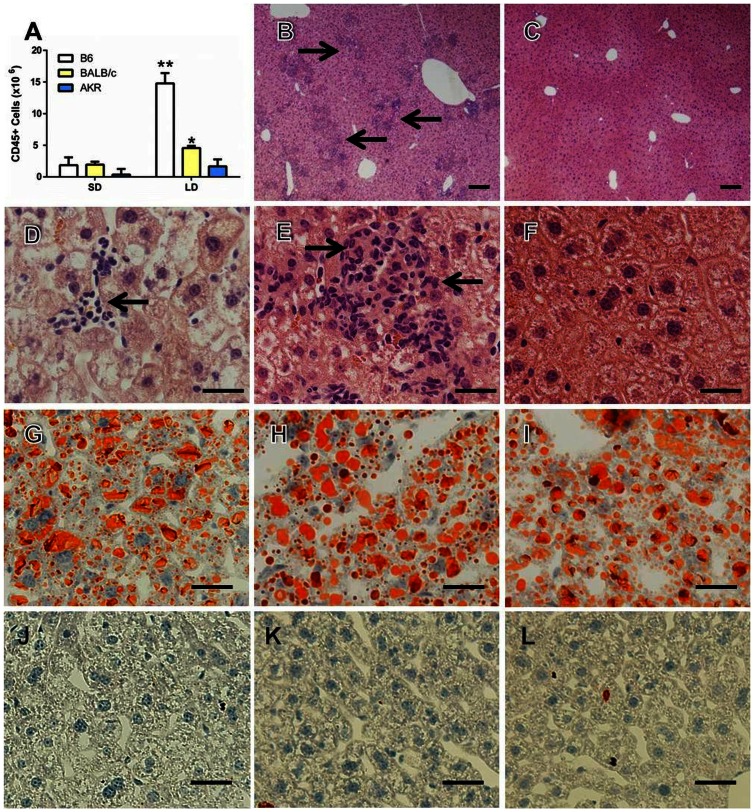
C57BL/6 mice are highly susceptible to diet induced hepatitis.(A) Liver leukocytes (CD45+ cells) were quantified in C57BL/6 (B6), BALB/c, and AKR mice fed either a standard diet (SD) or 4 weeks of lithogenic diet (LD) (*P<0.05 compared to SD controls, **P<0.05 compared to all groups; n = 3–5 per group). (B and E) H&E staining of liver from LD fed B6 mice under low and high power magnification respectively. Arrows in B point to inflammatory foci and E shows a representative inflammatory focus. (C and F) H&E staining of liver from LD fed AKR mice under low and high power magnification respectively. Oil-red-O staining showing lipid accumulation in BALB/c (G), B6 (H) and AKR mice (I) fed the LD but not in those fed the SD (J–L). Bars in B and C = 100µm; bars in D–L = 20µm.